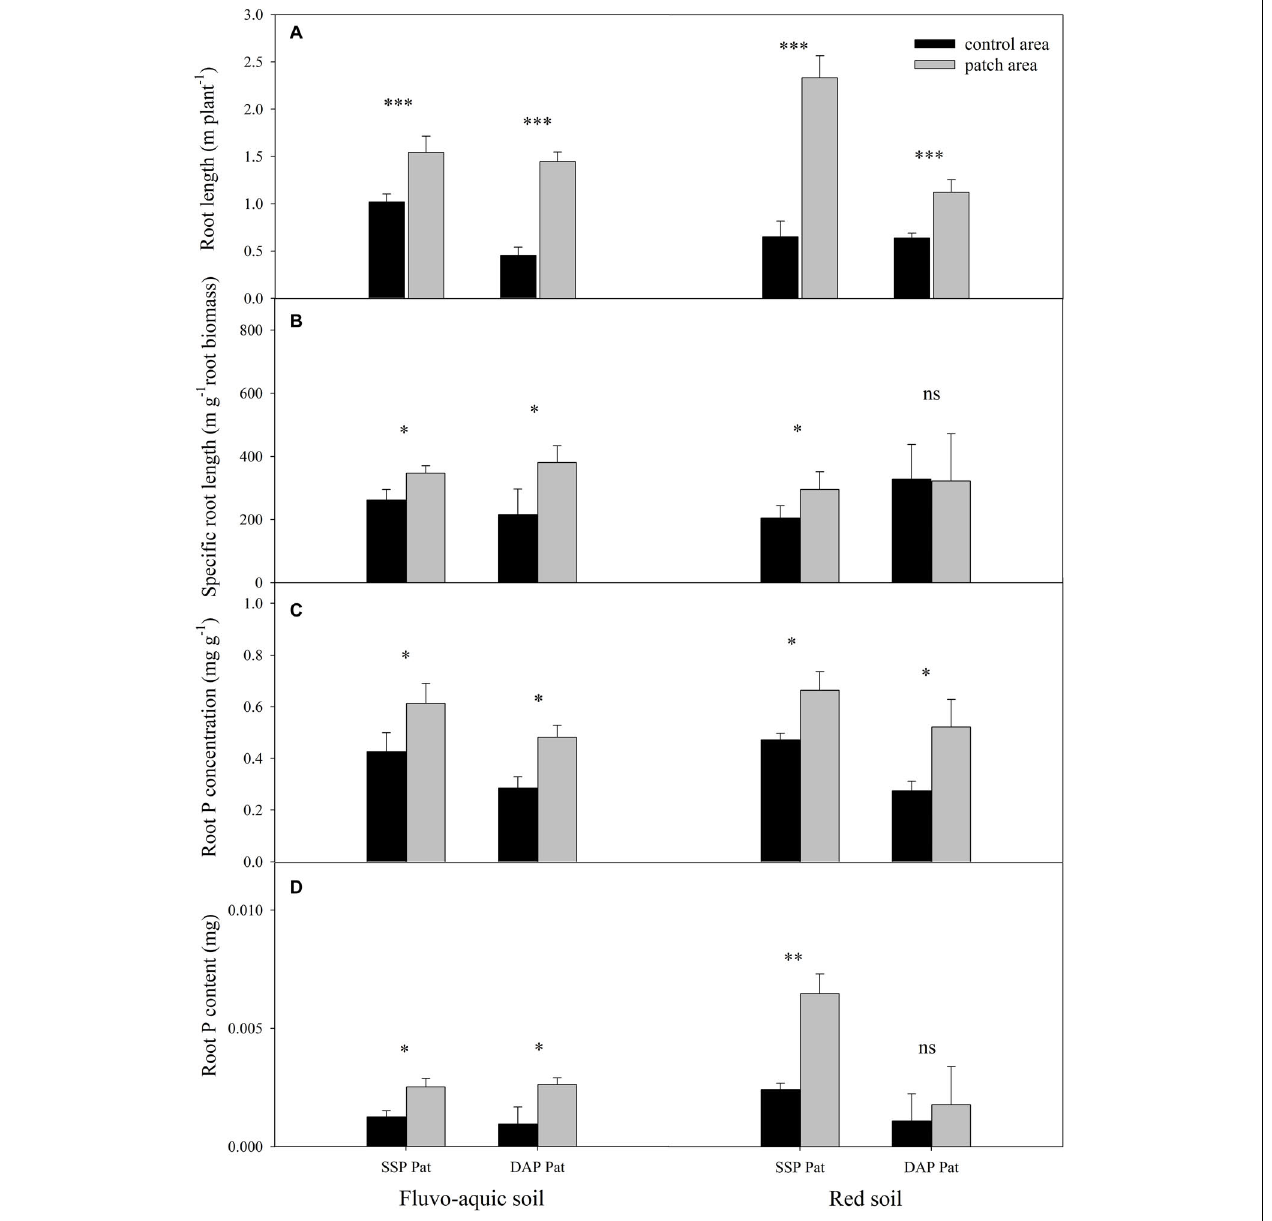
FIGURE 2 | Root length (A) , specific root length (B) , root P concentration (C) , and content (D) of maize in P-rich patches and contrast areas on 30 DAS in fluvo-aquic soil and red soil with localized P supply. A set of columns (black and gray) indicates sampled from the same rhizobox. Asterisks indicate significant differences between P-rich patches and contrast areas in the same rhizobox (significance level: ∗ P < 0.05; ∗∗ P < 0.01; ∗∗∗ P < 0.001; ns, no significant). Each column refers to the mean values of four replicates